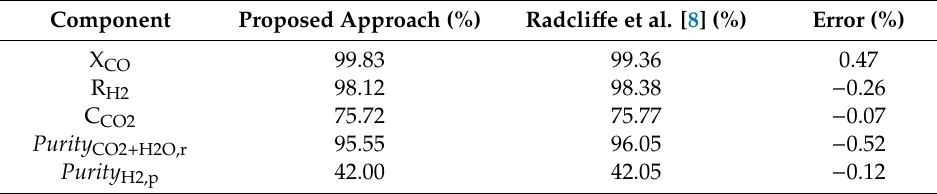
Table 3. Comparison between the block-based proposed approach and literature [8].